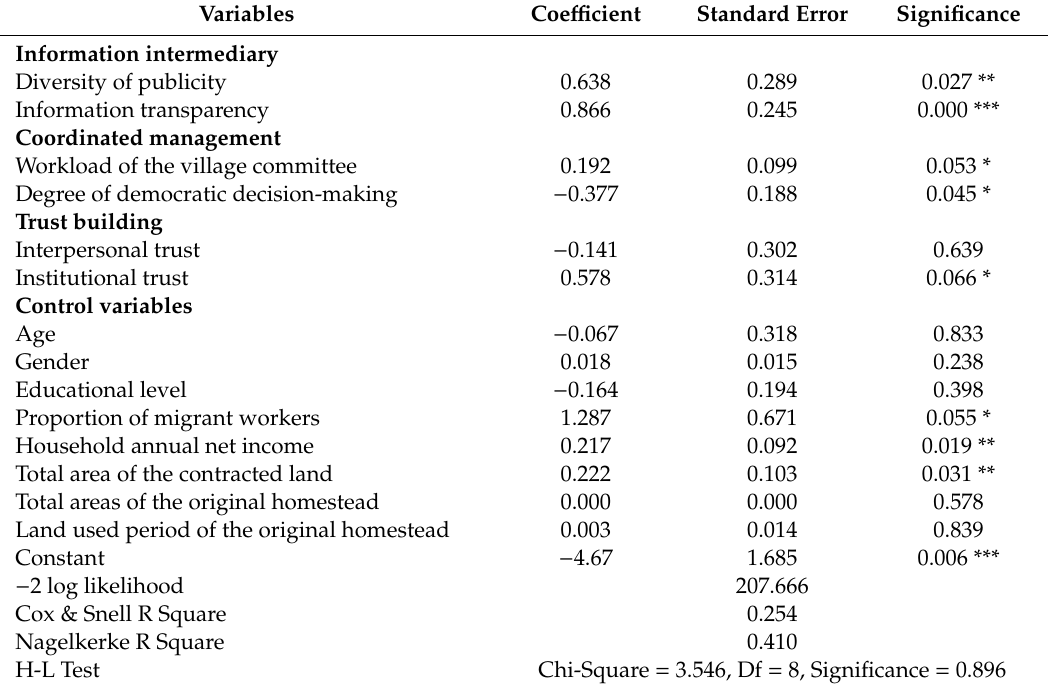
Table 4. Results of the binary logistic regression (BLR) model